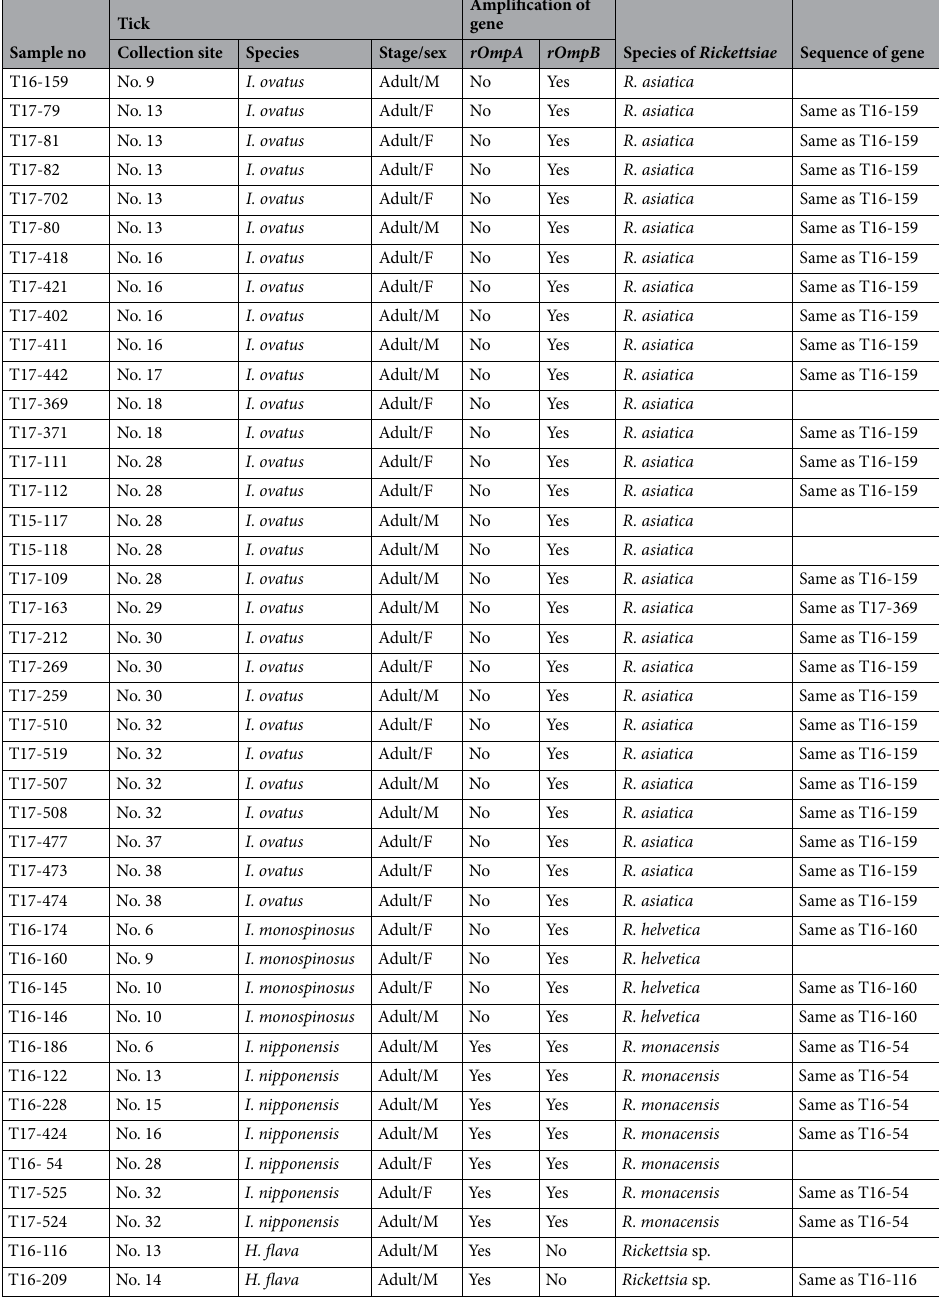
Table 4. Confirmed species/genus of SFGR in this study by